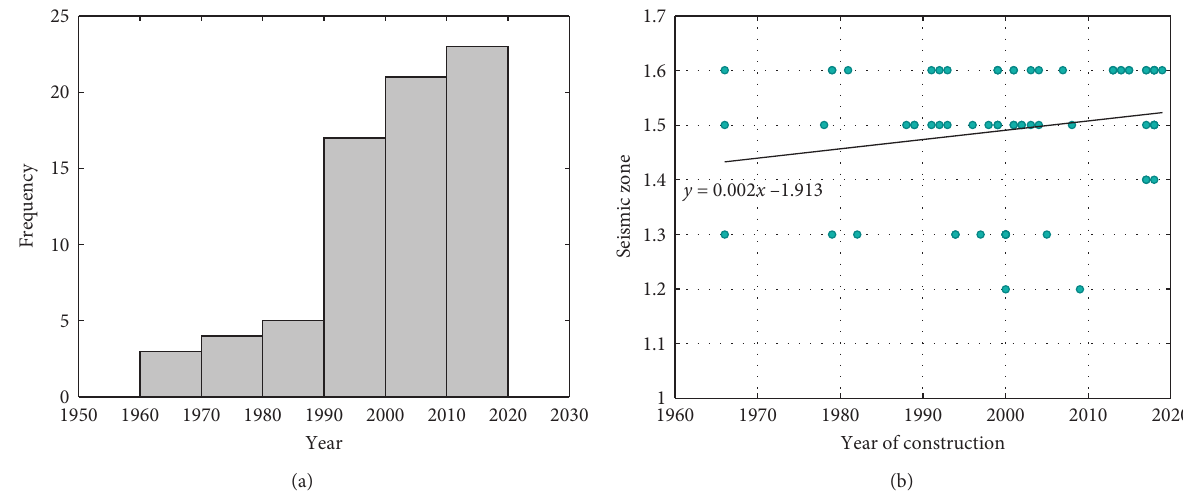
Figure 7: (a) Distribution of number of buildings analysed by the year of the project. (b) Evolution of the seismic zone with the year of the project.